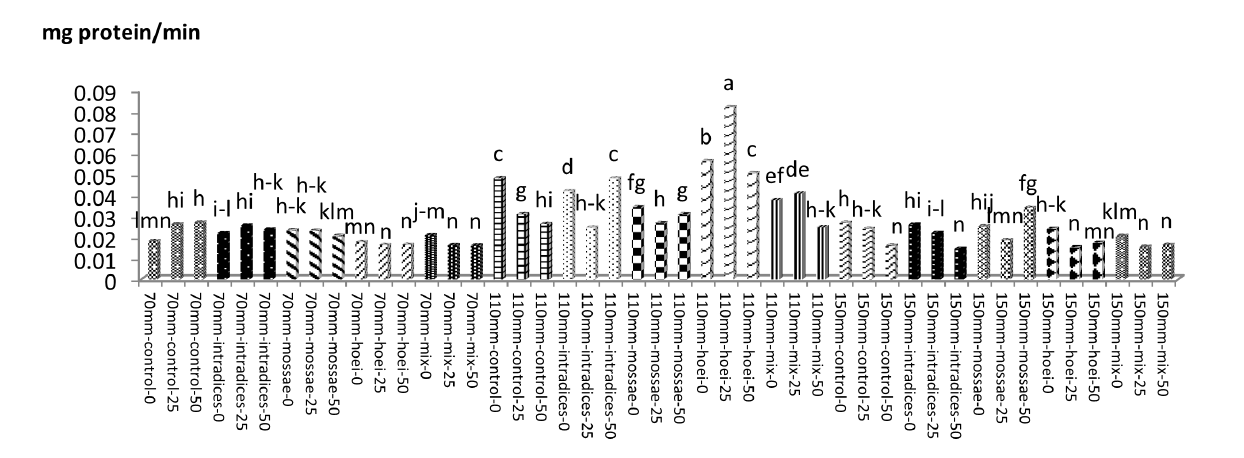
Figure 13 Effect of arbuscular mycorrhization and P fertilizer levels under different irrigation regimes on catalase activity.